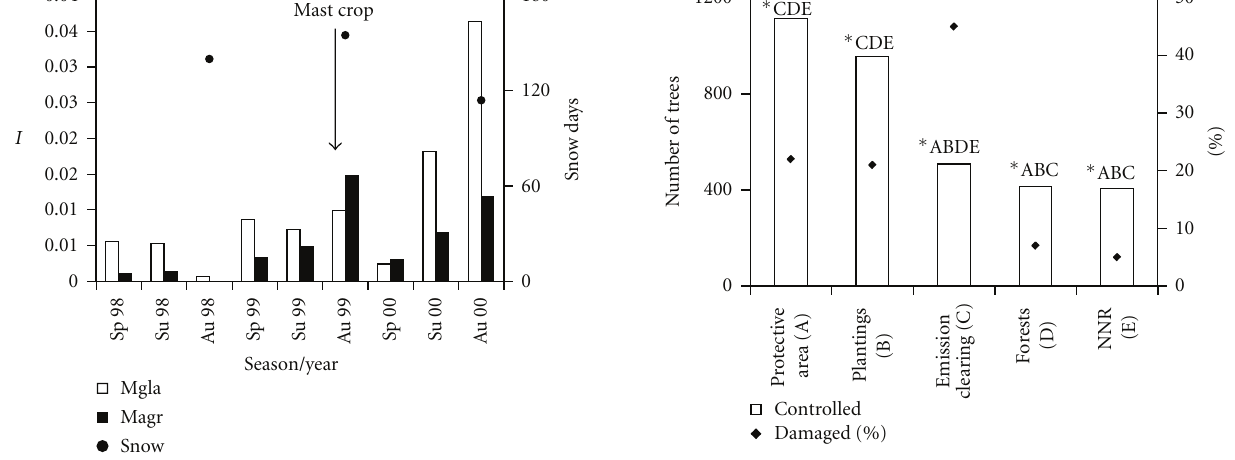
Figure 1: Fluctuation of the relative abundance ( I ) of vole species in the NNR. (Mgla: M. glareolus; Magr: M. agrestis ). ↓ good mast crop; • number of days with snow cower/year.